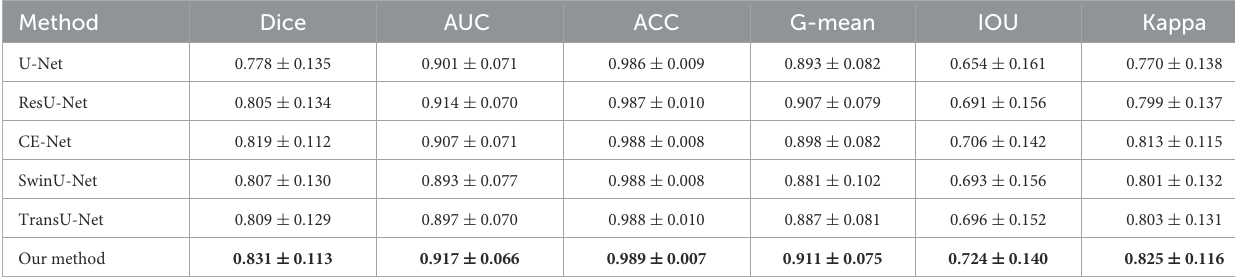
TABLE 1 LAA segmentation performance of comparison methods on TEE images.